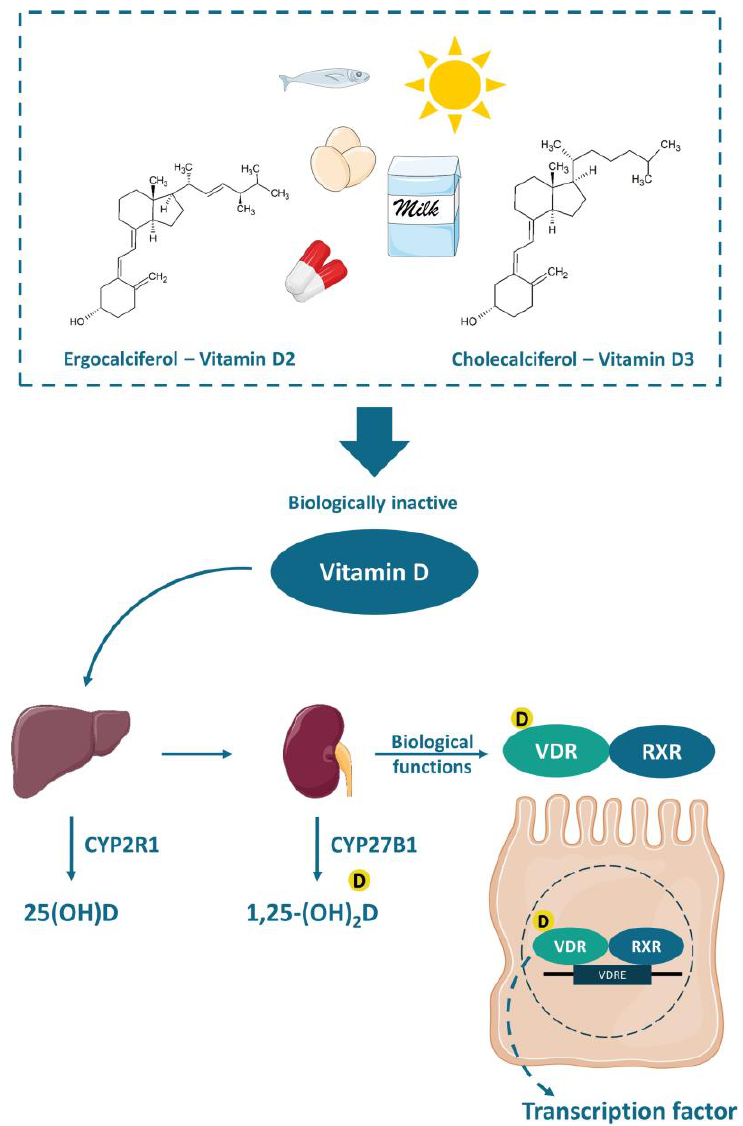
Figure 2. Chemical structure and activation of vitamin D. The vitamin D obtained by the exposure of skin to sunlight or consumed in food or supplements is transported to the liver and converted to 25(OH)D (25-hydroxyvitamin D) by the enzyme 25-hydroxylase (CYP2R1). Thereafter, a second hydroxylation occurs in the kidneys by the enzyme 1- α -hydroxylase (CYP27B1) generating the active vitamin D (1,25-(OH) 2 D or 1,25-dihydroxyvitamin D), which biological functions are mediated by the VDR (vitamin D receptor). The VDR bounded to 1,25-(OH) 2 D forms a heterodimer with the retinoic acid receptor (RXR), which in turn attaches to the vitamin D-response element (VDRE) acting as a nuclear transcription regulator.